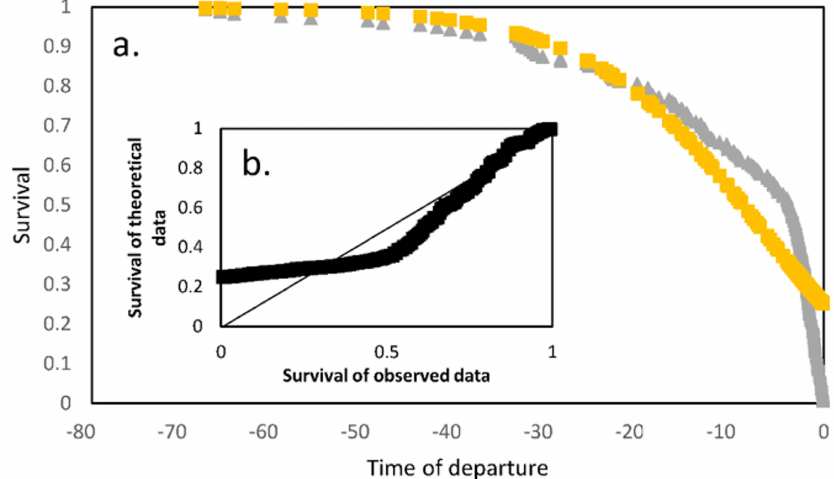
Figure 2. ( a ) Survival analysis of departure time (s) for the total dataset, i.e., at the red light (negative values) and at the green light (positive value) for the observed data (grey) and for the theoretical data (yellow); ( b) Survival values of theoretical data according to survival values of observed data. The thin black line represents the correlation we should observe between the two survivals if the rule underlying the departure of a pedestrian follows only one rule (here a sigmoid curve, Equation (1)). For Figure 2a, 0 indicates the time at which the light turns